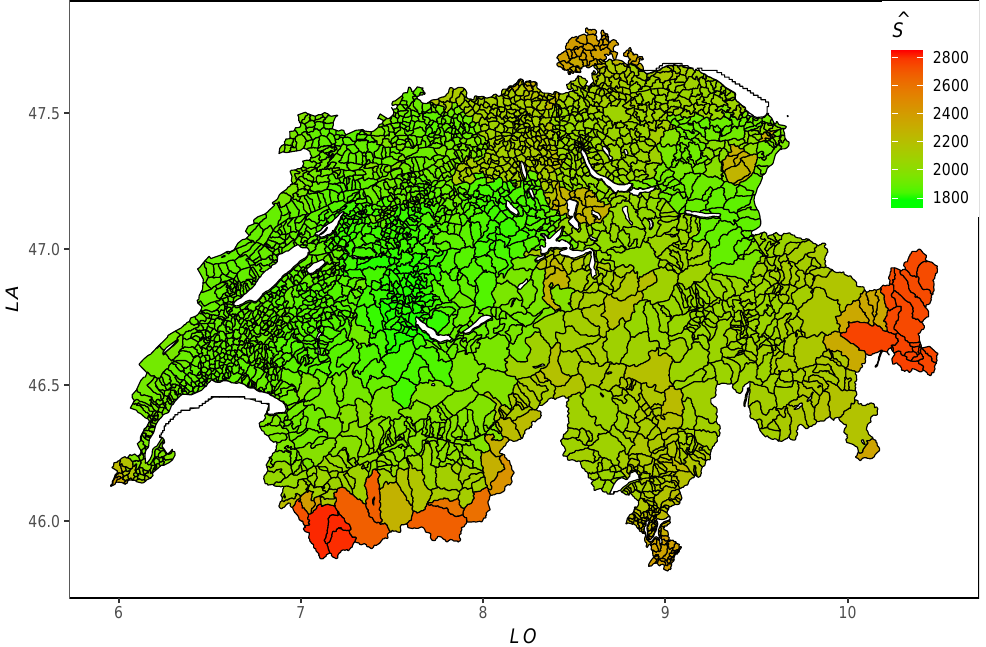
Figure 14. Illustration of the spatial claim severity predictions for the RF S